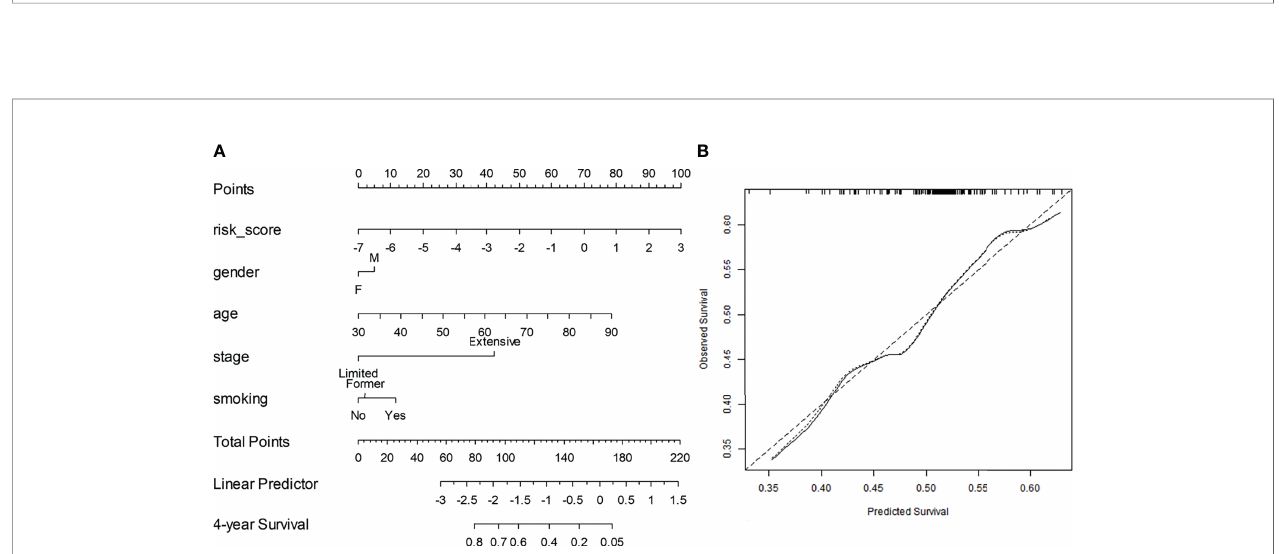
FIGURE 3 | (A) Integrated clinical and radiomic nomogram (N Rad+Clin ) for small cell lung cancer (SCLC) patients treated with systemic chemotherapy estimating the probability of surviving for 4 years. Instructions for reading the nomogram: locate the risk score on the risk score axis. Draw a line straight up to the Points axis to determine how many points toward the predicted probability of a 4-year overall survival (OS) that the patient receives for radiomic risk score level. Repeat this process for the other predictors, each time drawing a line straight up to the Points axis. Sum the points achieved for each predictor and locate this sum on the Total Points axis. Draw a line straight down to the 4-year Survival axis to determine the patient ’ s probability of surviving for 4 years. Variables with the greatest discriminatory value are those with the widest point range in the nomogram. Sample data from one patient is shown (tan arrows and ovals). (B) Calibration curve for 4-year survival. The x-axis shows the nomogram predicted probability, while the y-axis gives the actual 4-year survival as estimated by the Kaplan – Meier method. The dotted line represents an ideal agreement between actual and predicted probabilities of 4-year survival. The solid line represents N Rad+Clin nomogram, and the vertical bars represent 95% CIs. Dots correspond to apparent predictive accuracy.